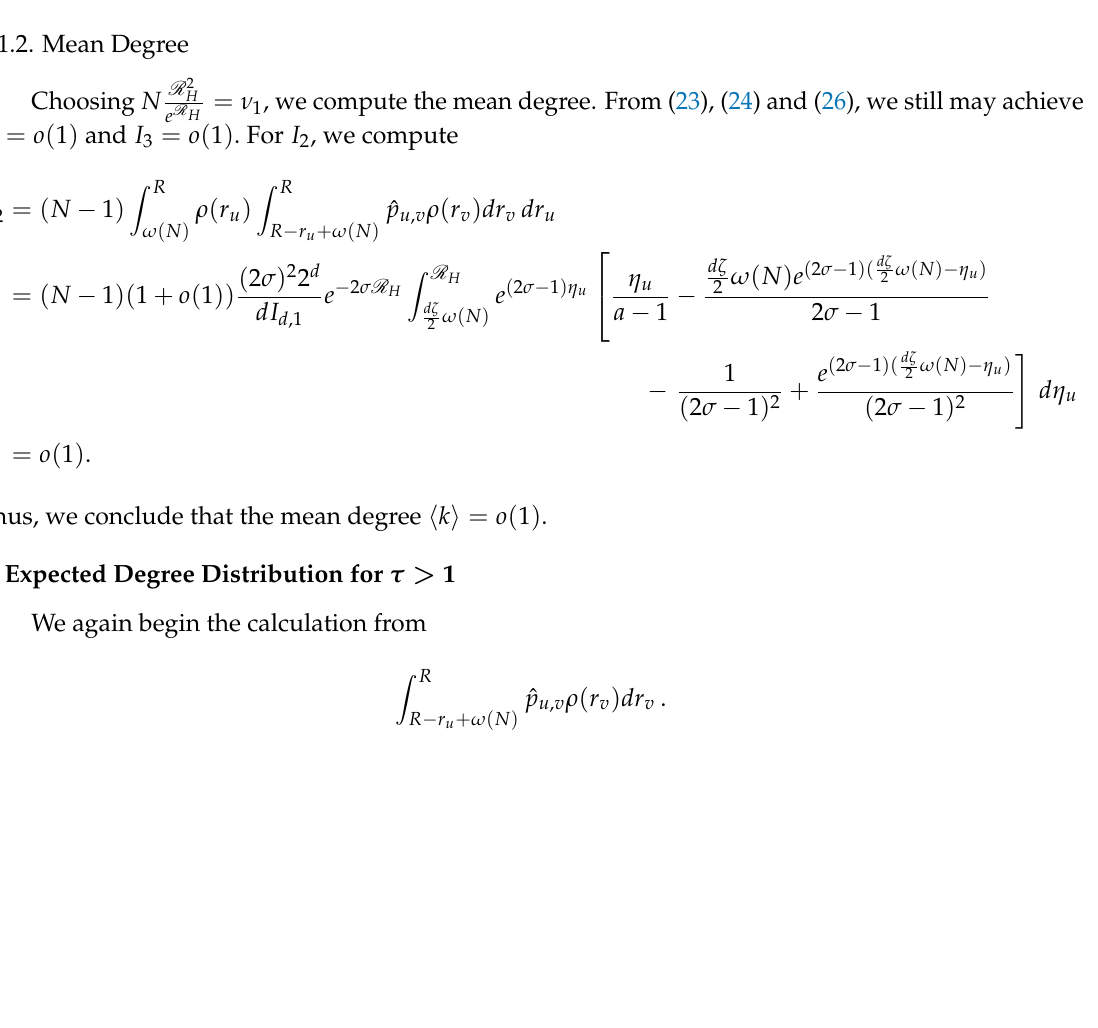
Figure 4. Plot of probabilities of node degrees having various values of k , against the network size N , for d = 2, τ = 1, 2 σ = 9/5, and ν = 1. Here, for the measured probabilities, we generate a single network for each N , and simply plot the number of nodes of degree k divided by N . Although we have not directly estimated the accuracy of these numbers, one can nevertheless see how Pr ( k ) → 0 for fixed k > 0 as N → ∞